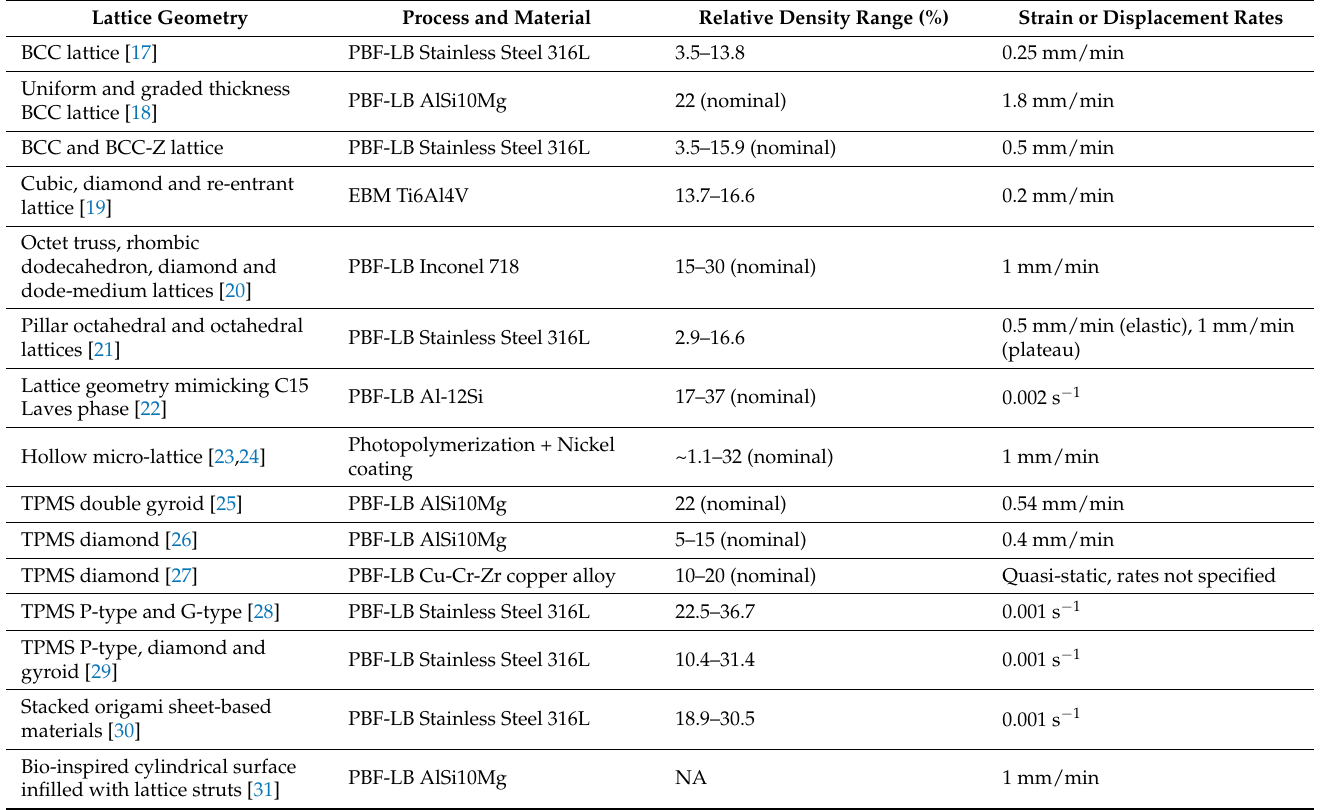
Table 1. Compilation of quasi-static energy absorption studies in lattice structures manufactured with metal additive